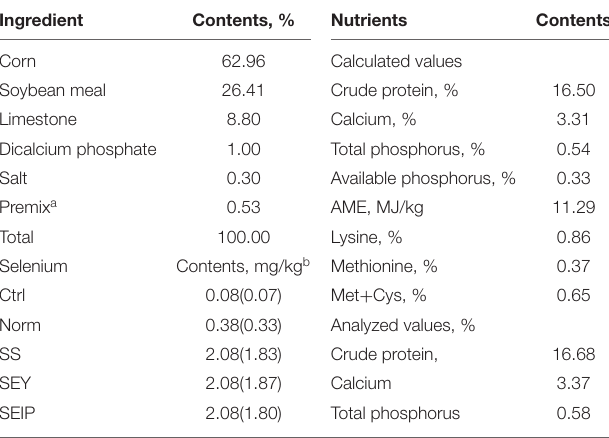
TABLE 1 | The composition and nutrient levels of experimental